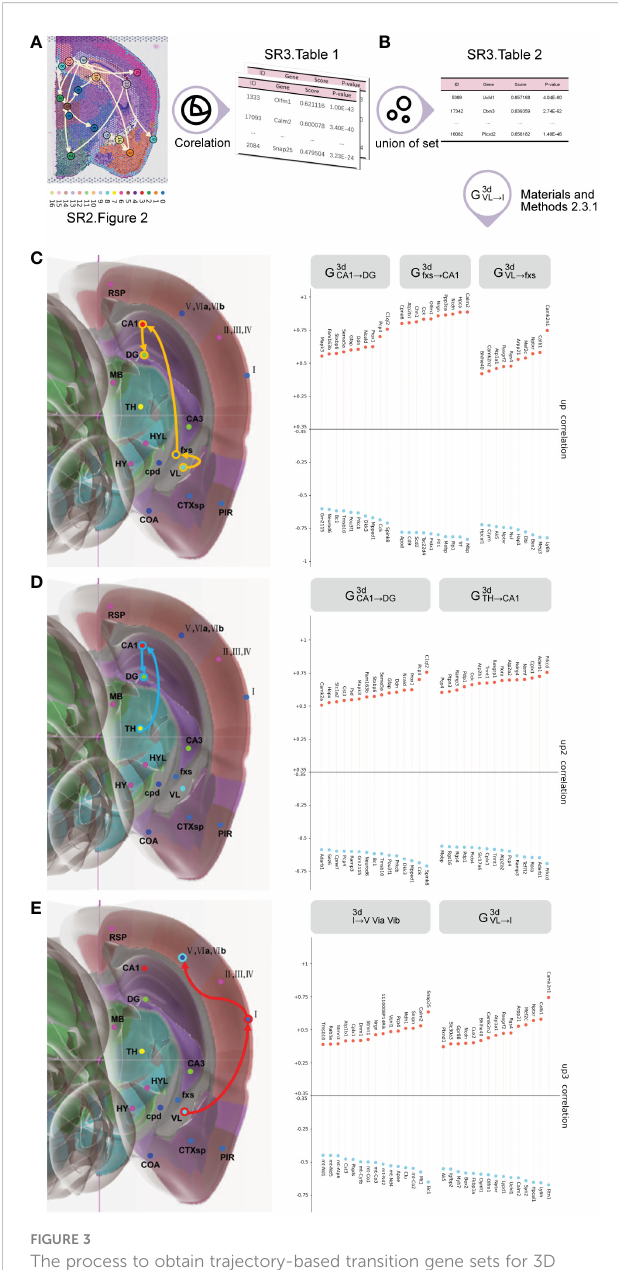
FIGURE 3 The process to obtain trajectory-based transition gene sets for 3D global pseudospace-time trajectories. (A) The top 30 planar up/ downregulated transition genes for each planar subtrajectory. (B) The top 30 3D up/downregulated transition genes for each 3D subtrajectory. (C) The top 30 3D trajectory-based transition gene sets of VL ! fxs ! CA1 ! DG. (D) The top 30 3D trajectory-based transition gene sets of TH ! CA1 ! DG. (E) The top 30 3D trajectory-based transition gene sets of VL ! I ! (V, VIa,